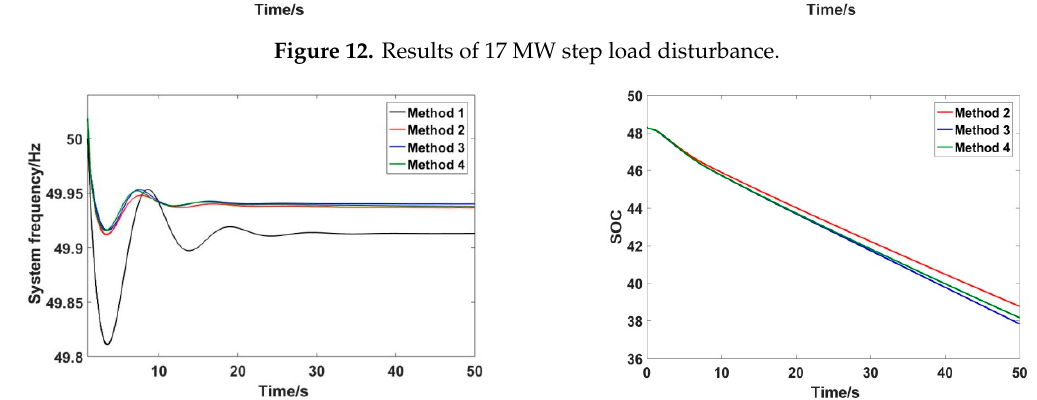
Figure 13. Results of 18 MW step load disturbance of.